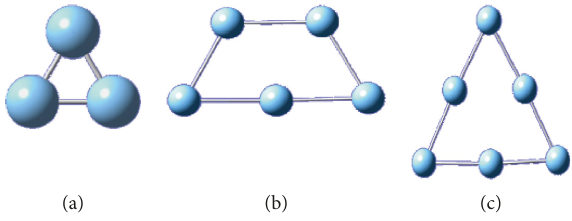
F IGURE 1: Silver cluster optimized and conserved: (a) cluster of 3 silver atoms, (b) cluster of 5 silver atoms, and (c) cluster of 6 silver